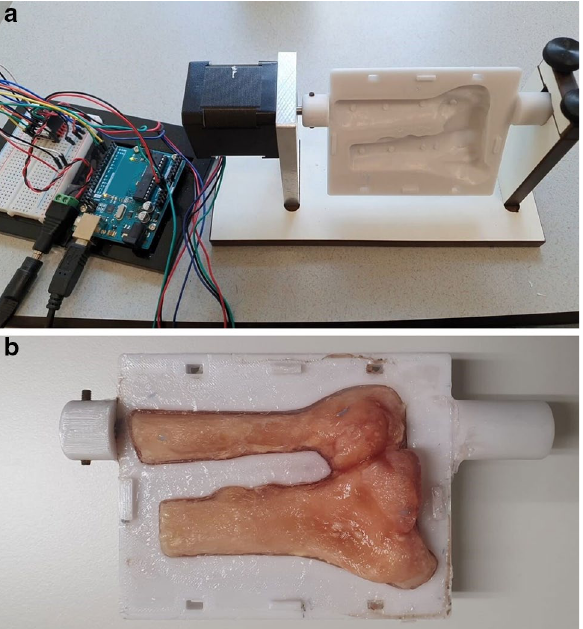
Figure 2. Motorized phantom: A: The wrist phantom attached to the computer controlled stepper motor with the rotation axis in line with the ulnar shaft. B: Wrist phantom with the DRUJ embedded in agarose